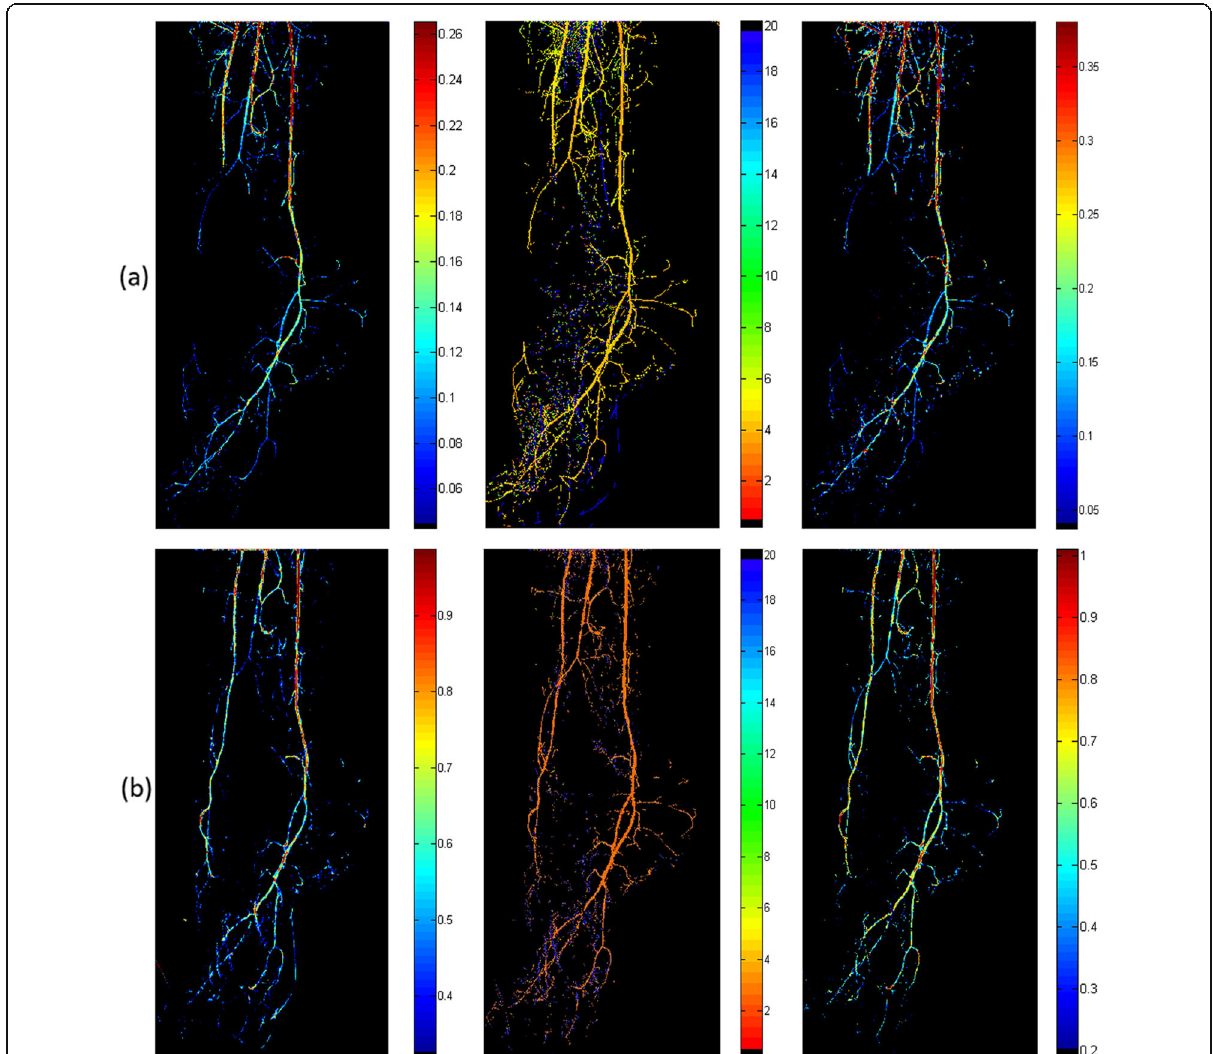
Fig. 5 a Preoperative PBV, MTT, and PBF maps (from left to right). b Postoperative PBV, MTT, and PBF maps (from left to right). PBV Perfusion blood volume, MTT Mean transit time, PBF Perfusion blood